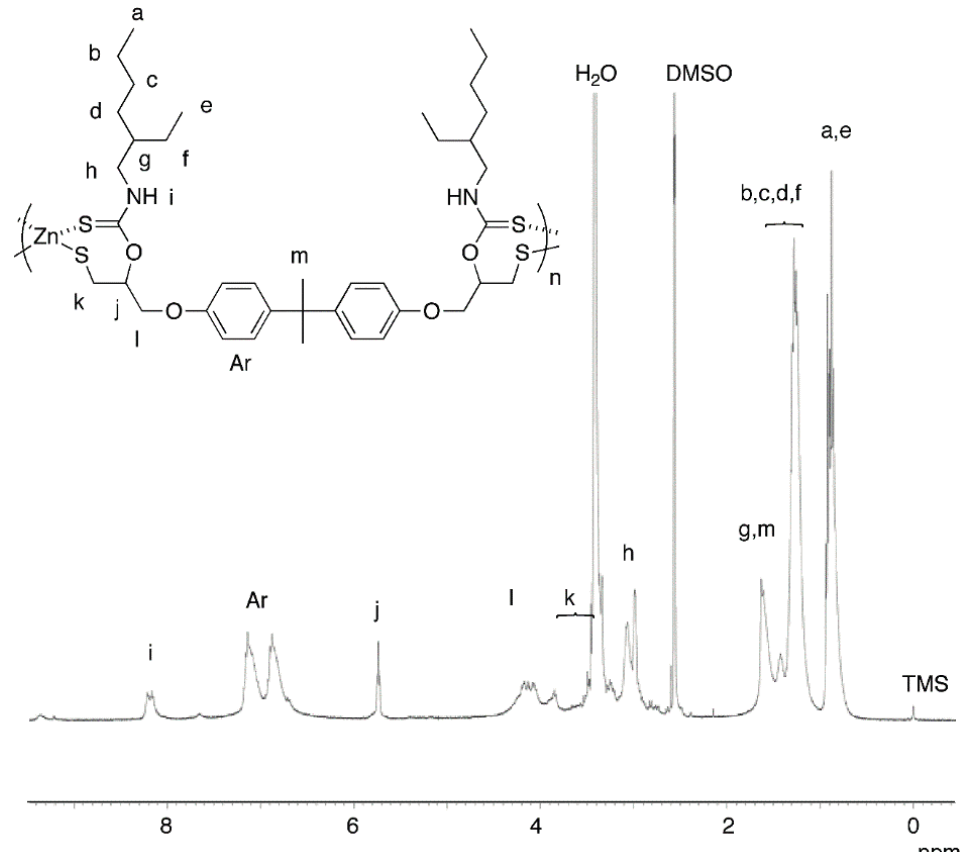
Figure 2. 1 H-NMR spectrum (400 MHz, DMSO -d 6 ) of the polymer obtained in run 1